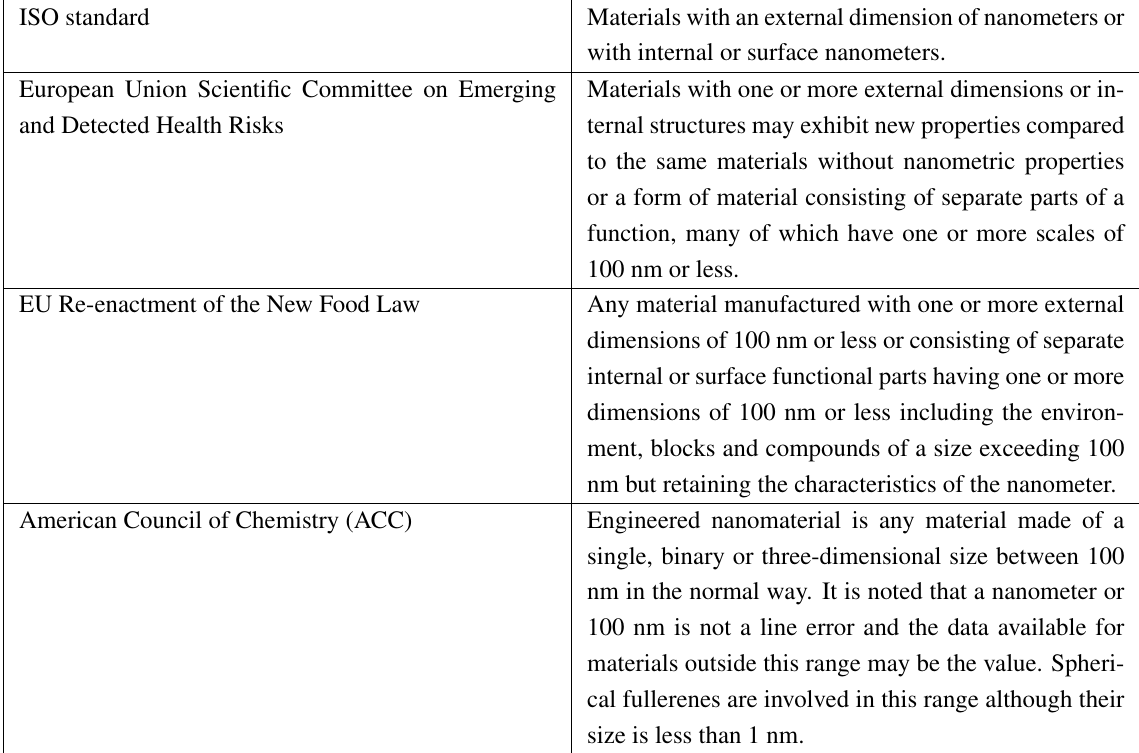
Table 1. Multiple Terms from Different Nanomaterials (World Health Organization (”World Health Organization”, n.d.) ISO